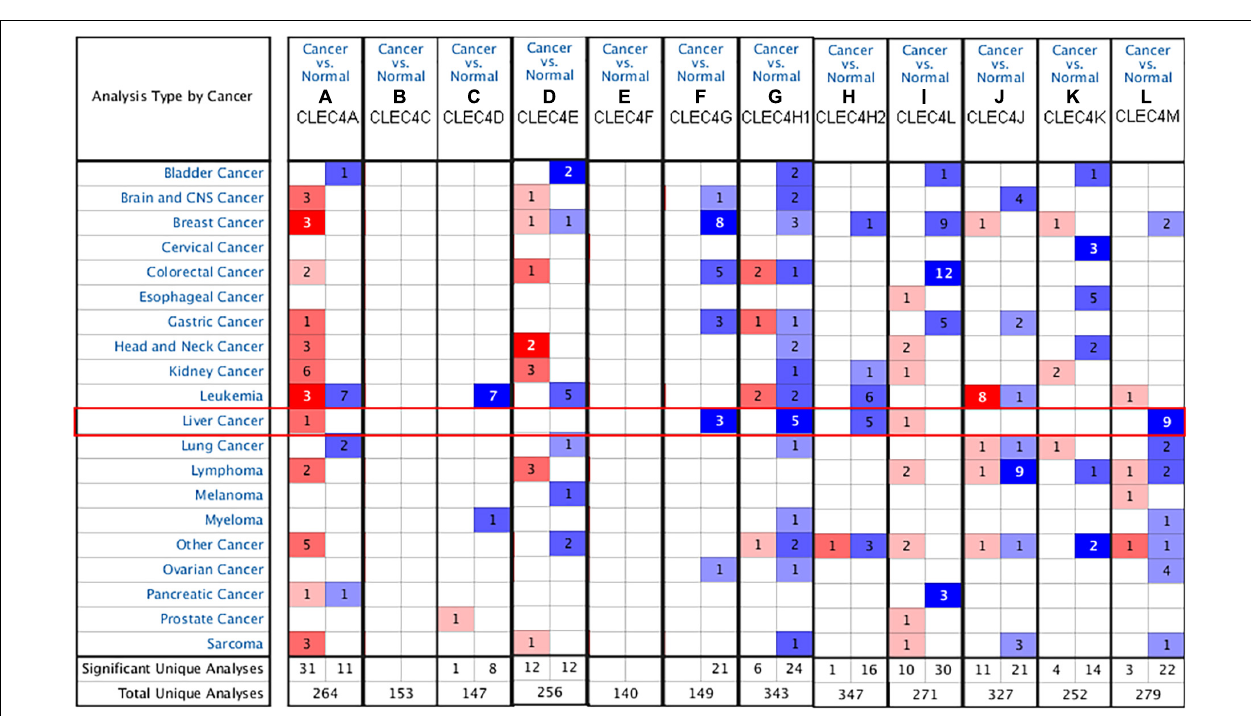
Frontiers in Cell and Developmental Biology |